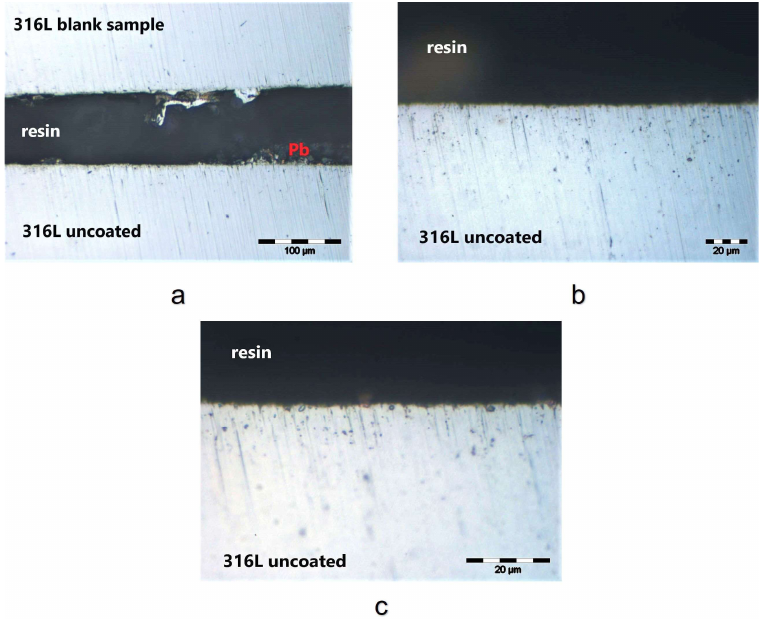
Figure 11. Cross section of a AISI 316L uncoated specimen after being tested for 500 h in liquid lead at different magnifications: 200 × ( a ), 500 × ( b ), and 1000 × ( c